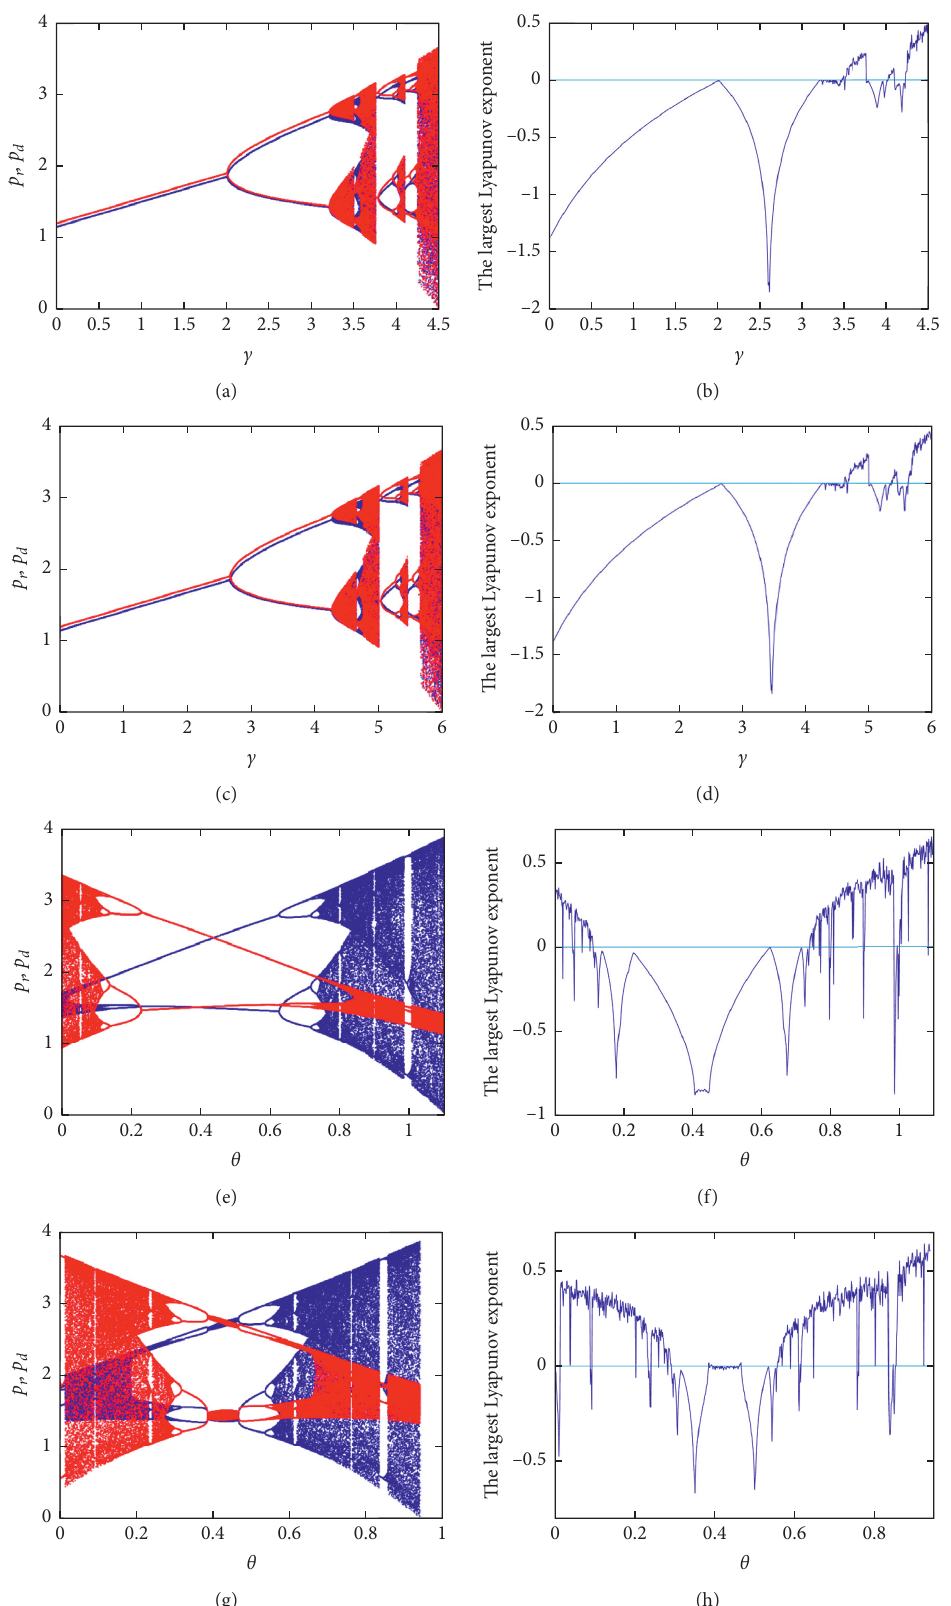
Figure 3: 1D bifurcation diagram with respect to green preference coefficient c and retail preference channel coefficient θ and their corresponding maximum Lyapunov exponent diagrams. Select a set of parameter values as v r � 0 . 8587, v d � 0 . 849, ξ � 1 . 4896, β � 0 . 0519, α � 0 . 597, w � 1 . 1462, and c � 0 . 8133, where (a) e � 0 . 3019 and θ � 0 . 4183, (c) e � 0 . 4019 and θ � 0 . 4183. Figures 3(b) and 3(d) are the maximum Lyapunov exponent diagrams corresponding to Figures 3(a) and 3(c), where (e) e � 2 . 1019 and c � 0 . 5171, (g) e � 2 . 5019 and c � 0 . 5171. Figures 3(f) and 3(h) are the maximum Lyapunov exponent graphs corresponding to Figures 3(e) and